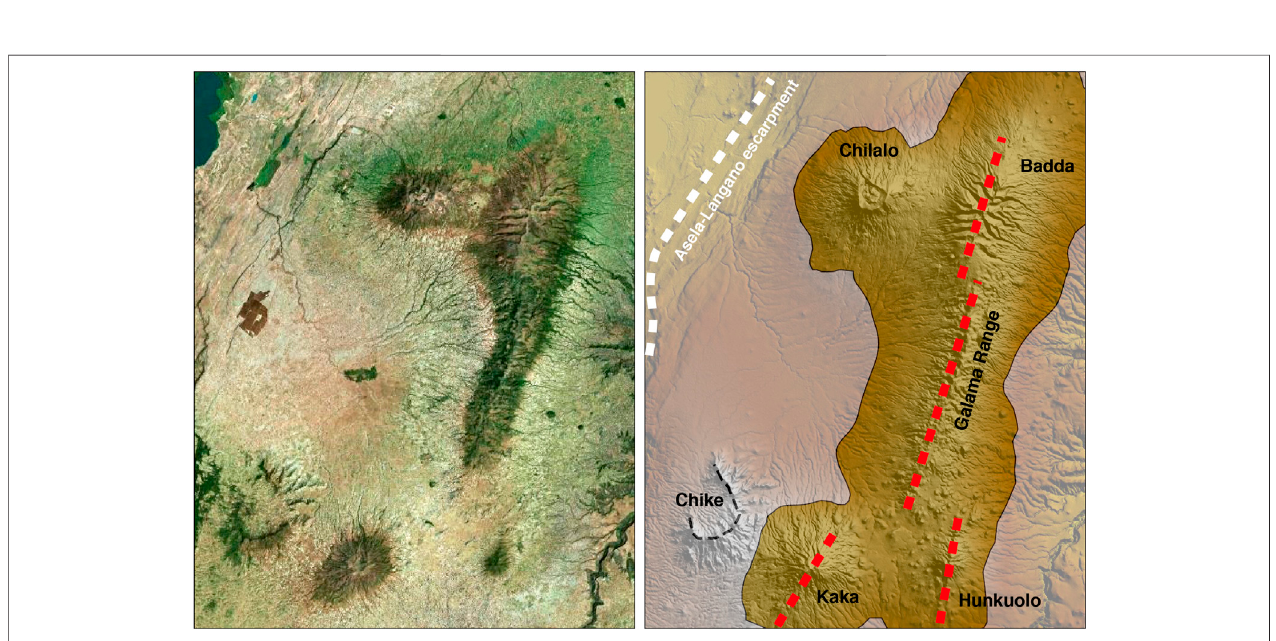
FIGURE 12 | Satellite image (left) and main off-axis volcanoes (right) in the Somalian Plateau. Red dashed lines indicate the trend of inherited fabrics that possibly feed the volcanoes.